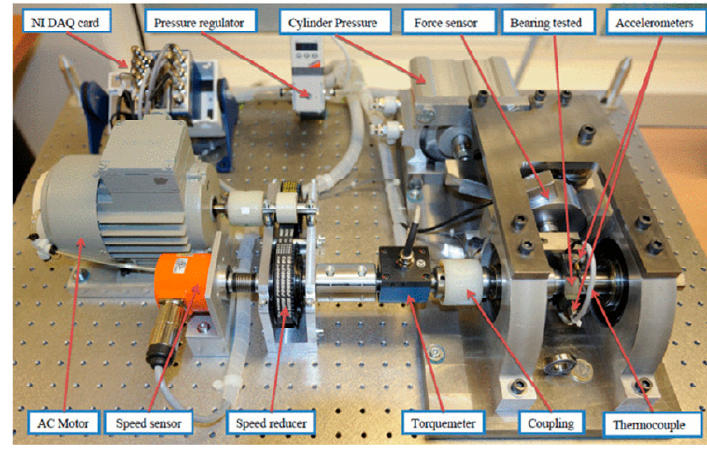
Figure 10. PRONOSTIA platform.